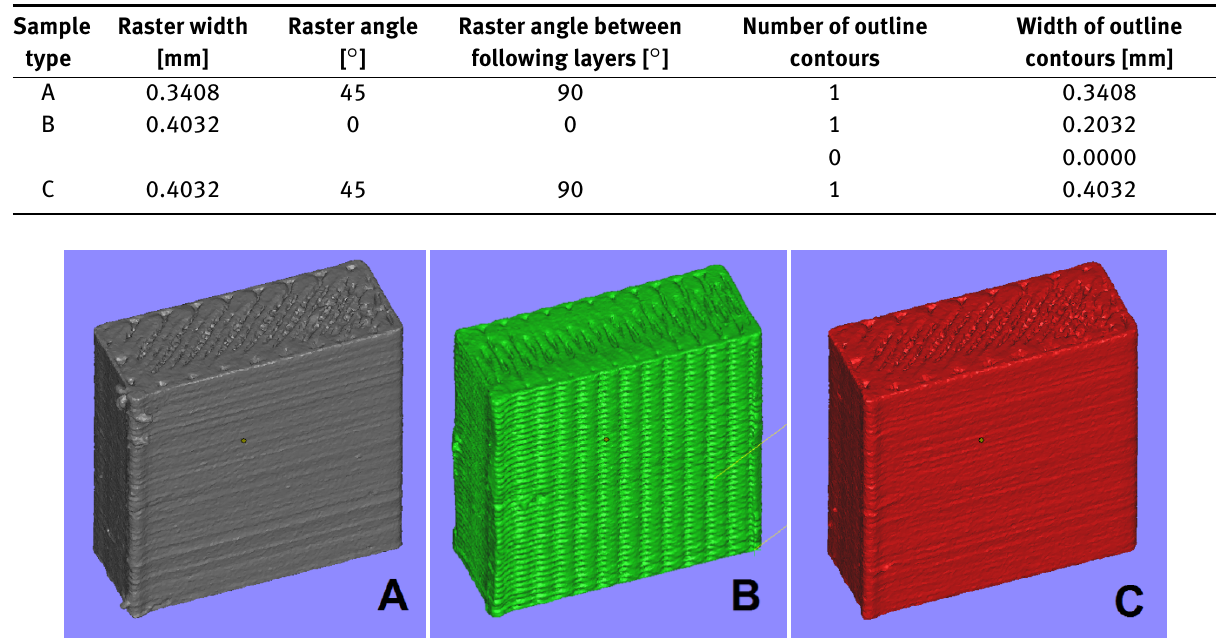
Table 1: Path generation strategies used in experiments.